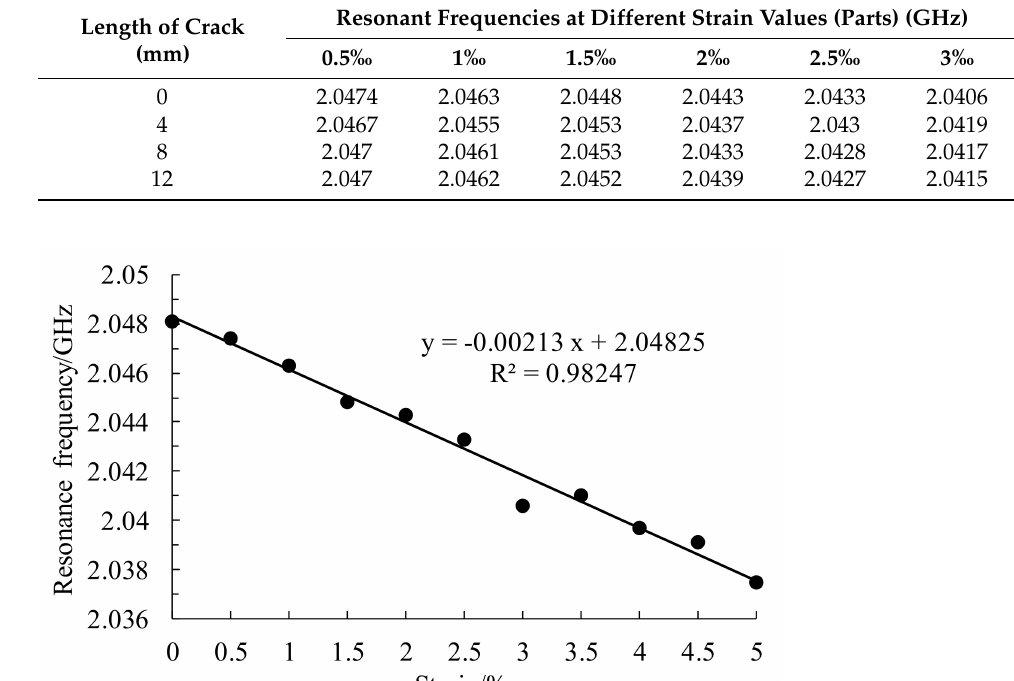
Table 3. Relationship between strain and resonant frequency at different crack lengths.